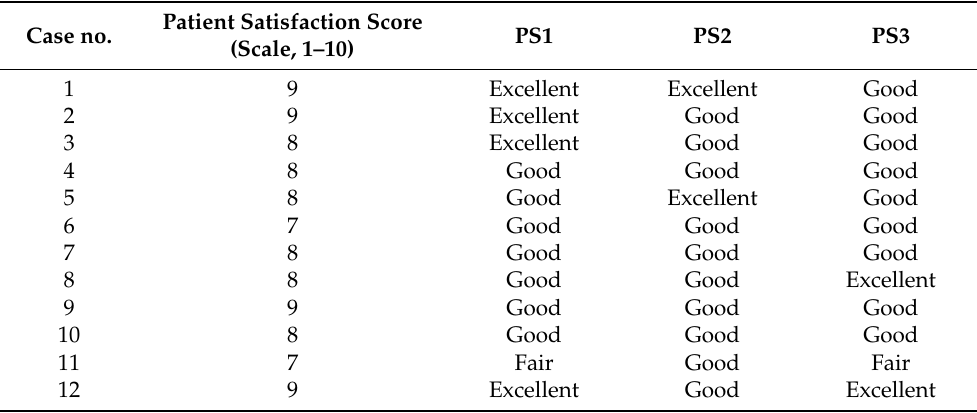
Table 2. Outcomes of the final scar appearance were evaluated using the patient satisfaction surveys and Harris 4-stage scale by three independent plastic